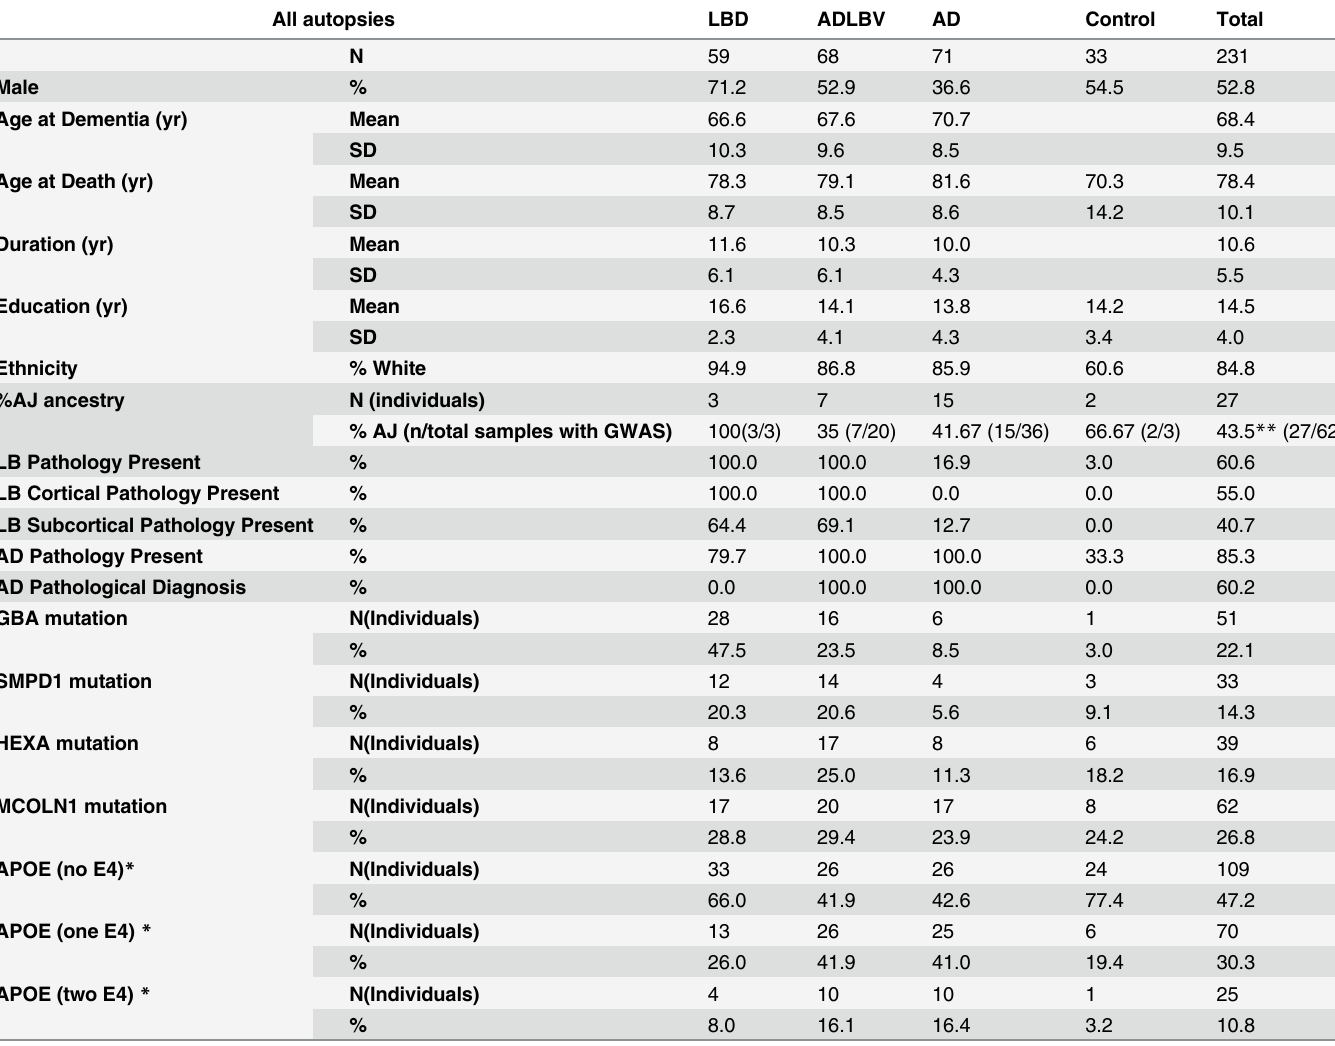
Table 1. Characteristics of Autopsy